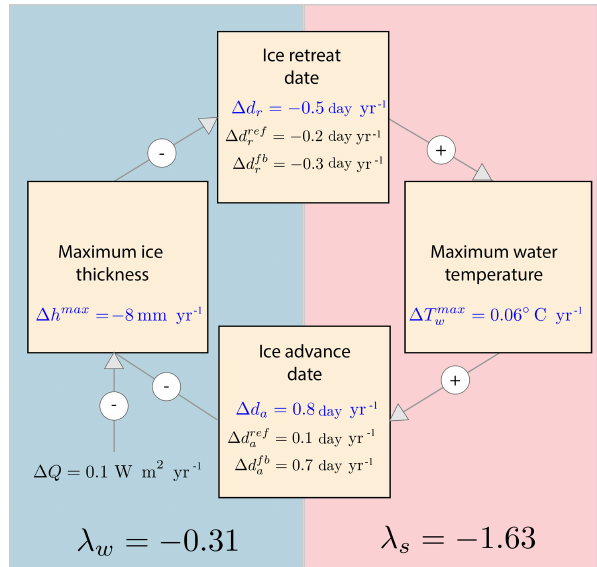
Figure 5. Schematics of the mechanisms shaping the thermody- namic response of sea ice seasonality to a radiative forcing per- turbation. The numbers give annual averages simulated by the 1-D model. Changes in ice retreat and advance dates are split between reference (ref) and feedback (fb) responses. See Appendix A for details of the